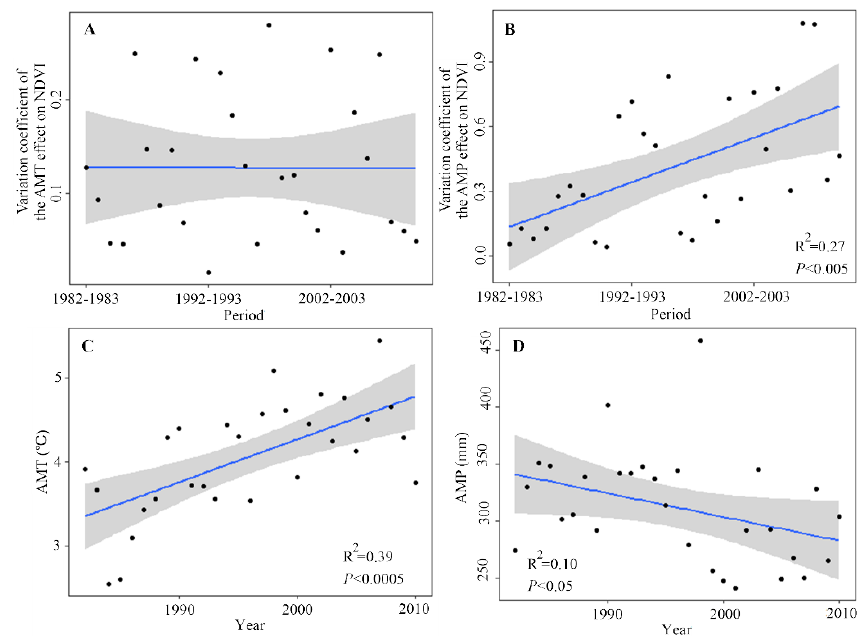
Figure 4. The variation coefficient of the climate effect on NDVI from 1982 to 2010 (variation coefficient of the AMT effect on NDVI ( A ) and variation coefficient of the AMP effect on NDVI ( B )); and the dynamic of AMT ( C ) and AMP ( D ) from 1982 to 2010. AMT, AMP, and NDVI represent the annual mean temperature, annual mean precipitation, and the normalized difference vegetation index, respectively.